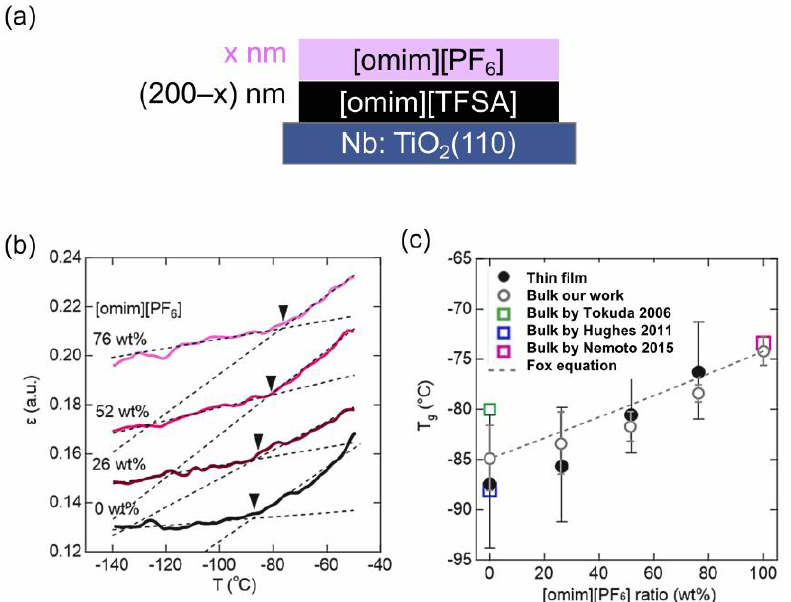
Figure 5. ( a ) Schematic of the bi-layer structure. ( b ) Series of the plots of ε against the temperature for the [omim][PF 6 ]/[omim][TFSA] bi-layer films. ( c ) T g plotted as a function of [omim][PF 6 ] weight fraction for [omim][PF 6 ]/[omim][TFSA] thin films (closed circle), [omim] [PF 6 ]-[omim][TFSA] bulk mixtures (open circle) and literature (open squares, [24 – 26]). The dashed line is a linear correlation between T g and the [omim][PF 6 ] weight fraction predicted from the Fox equation using the measured T g values of [omim][PF 6 ] and [omim][TFSA] bulk ILs (this work). Reproduced with permission from ref. [23]. Copyright 2020, Elsevier.